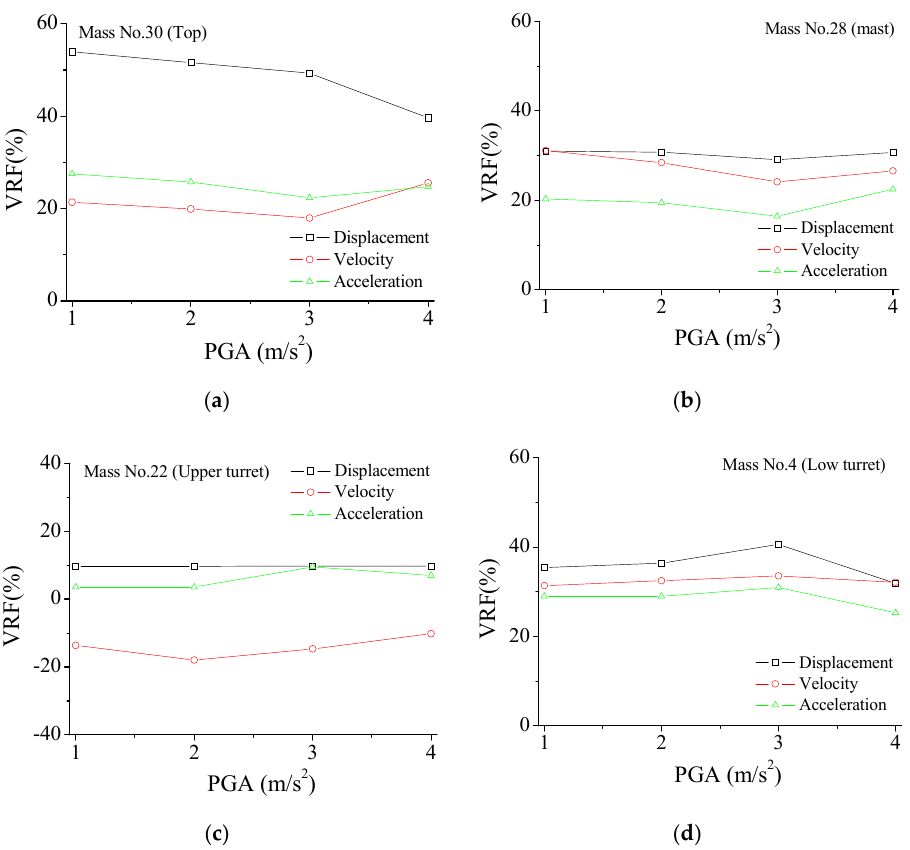
Figure 14. Variation of VRFs with seismic PGA. ( a ) VRF No. 30; ( b ) VRF No. 28; ( c ) VRF No. 22; ( d ) VRF No. 4. Table 4. VRFs of the TV transmission tower under different earthquakes